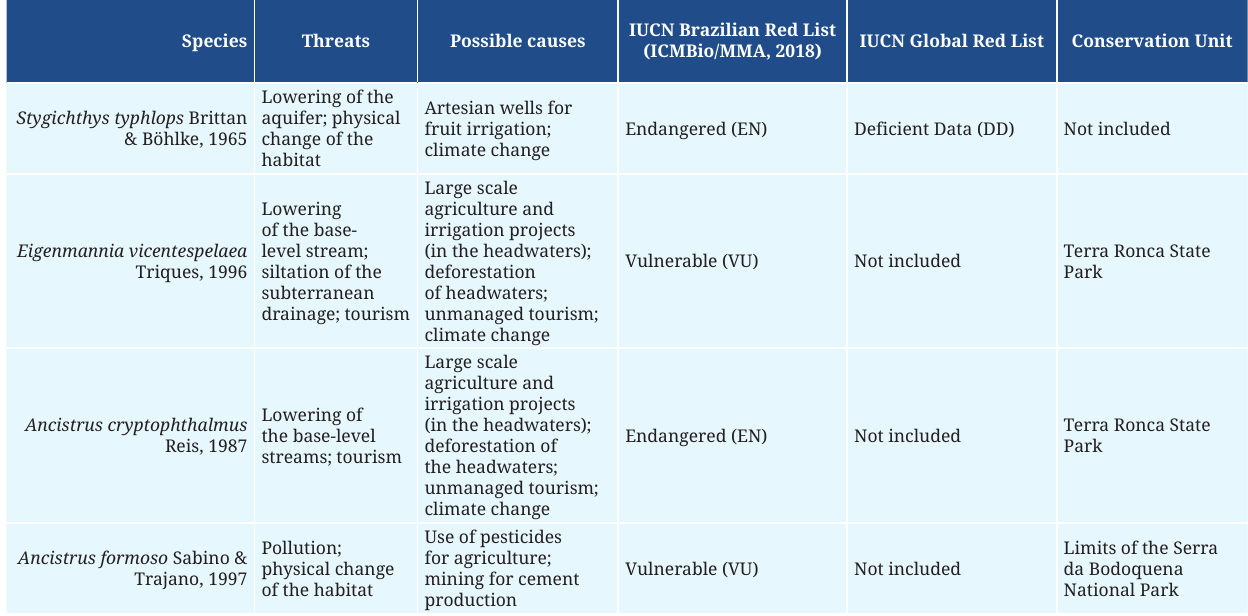
TABLE 2 | Brazilian subterranean fishes: threats, possible causes, IUCN categories, and occurrence in Conservation